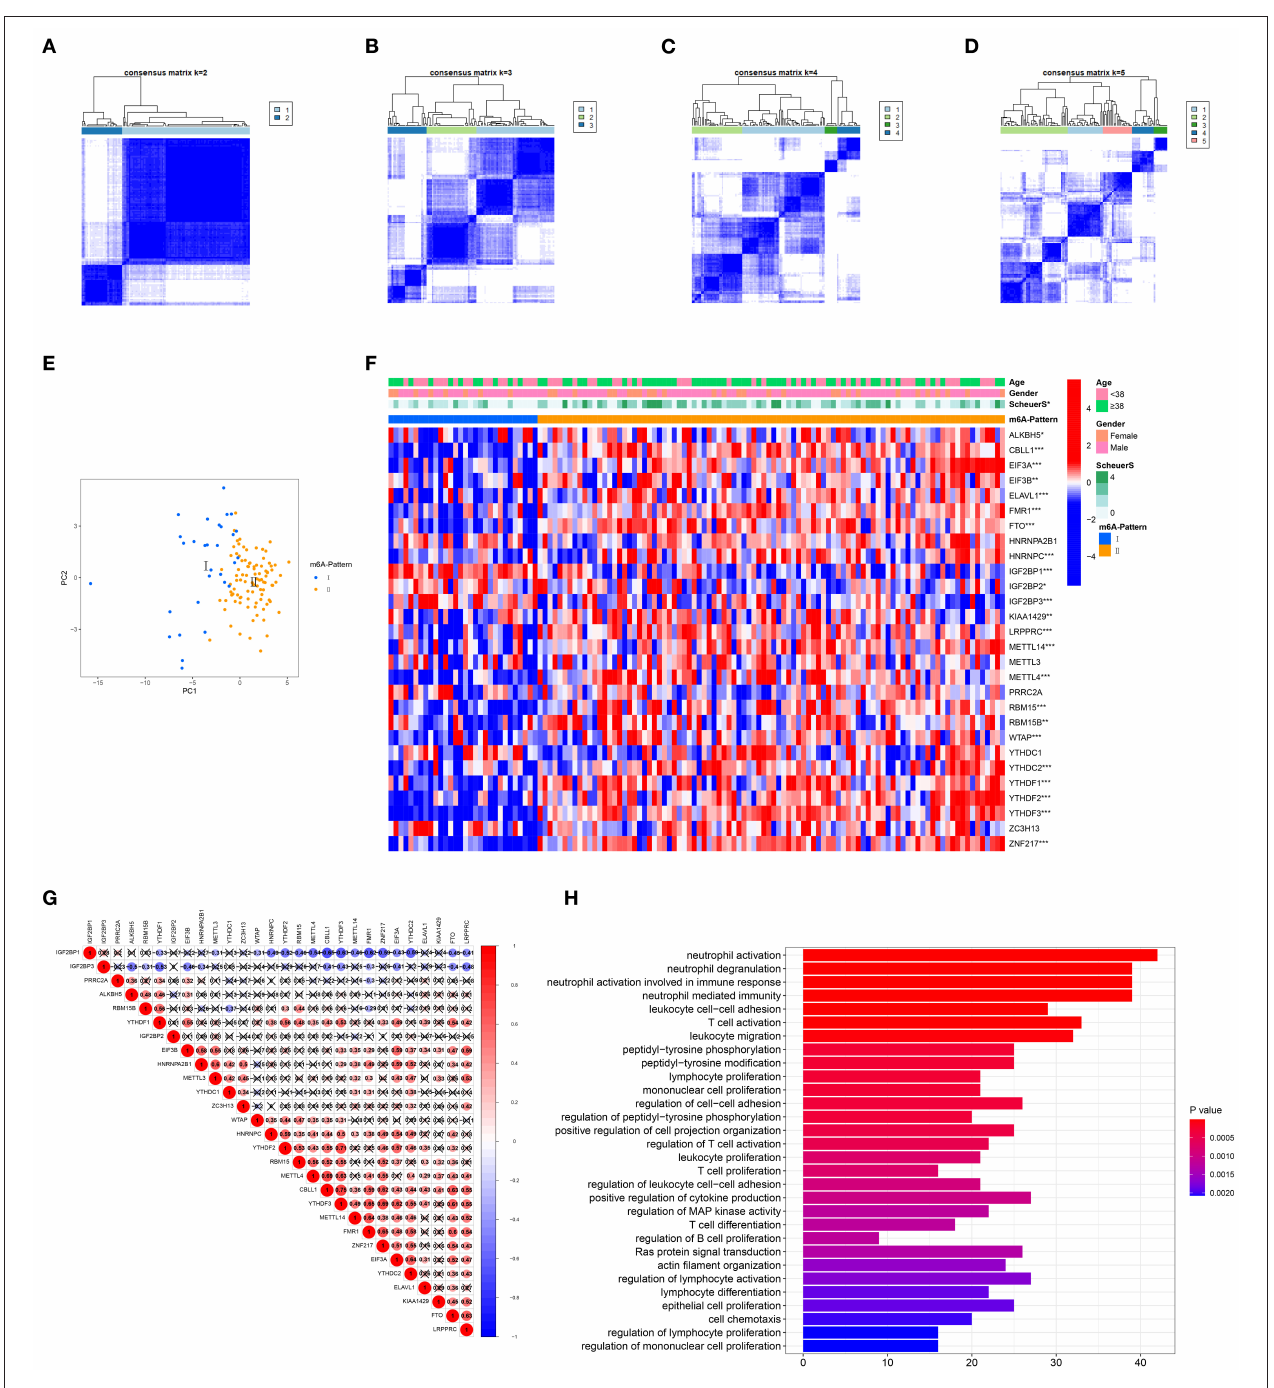
FIGURE 1 | Identification of N6-methyladenosine (m6A) modification patterns. (A–D) Consensus clustering of the 28 m6A regulators for k = 2–5. (E) Principal component analysis (PCA) for the expression profiles of m6A regulators showed a remarkable separation between the two m6A patterns. (F) Heatmap of the 28 m6A regulators and clinical traits in m6A-Pattern I and m6A-Pattern II. (G) Correlations among the m6A regulators. (H) Gene ontology analysis of m6A-and-stage related genes. “c2.cp.kegg.v7.4.symbols” downloaded from the Molecular Signatures Database (MSigDB). Adjusted p below 0.01 and |logFC| > 0.1 were considered as